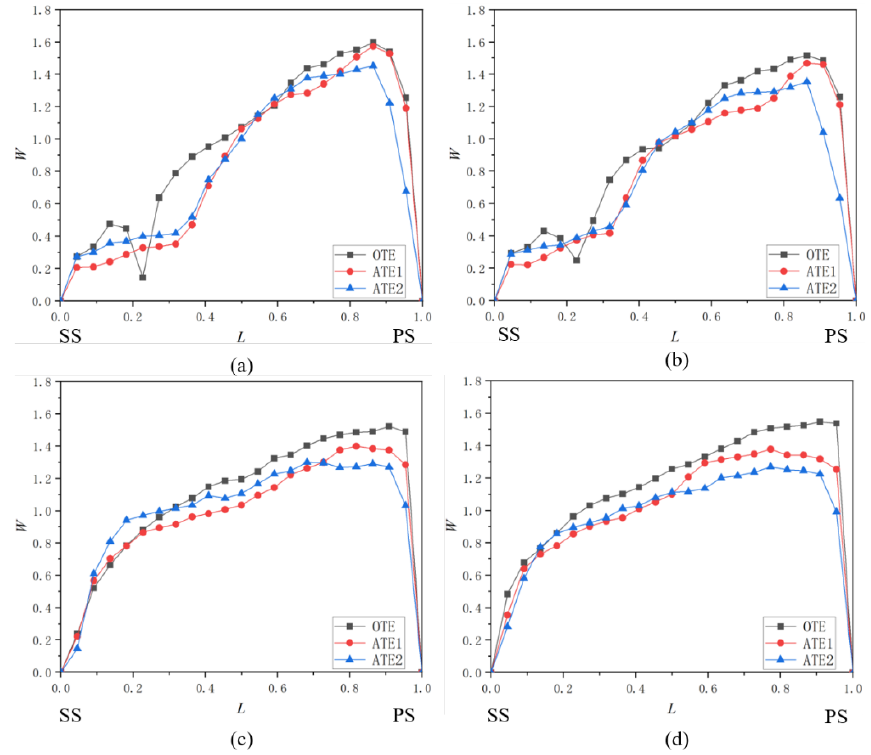
Figure 8. Blade-to-blade distributions of the relative velocities at R/R 0 = 0.9: ( a ) 0.2 Q BEP ; ( b ) 0.4 Q BEP ; ( c ) 1.0 Q BEP ; and ( d ) 1.2 Q BEP . ( c ) 1.0 Q BEP ; and ( d ) 1.2 Q BEP